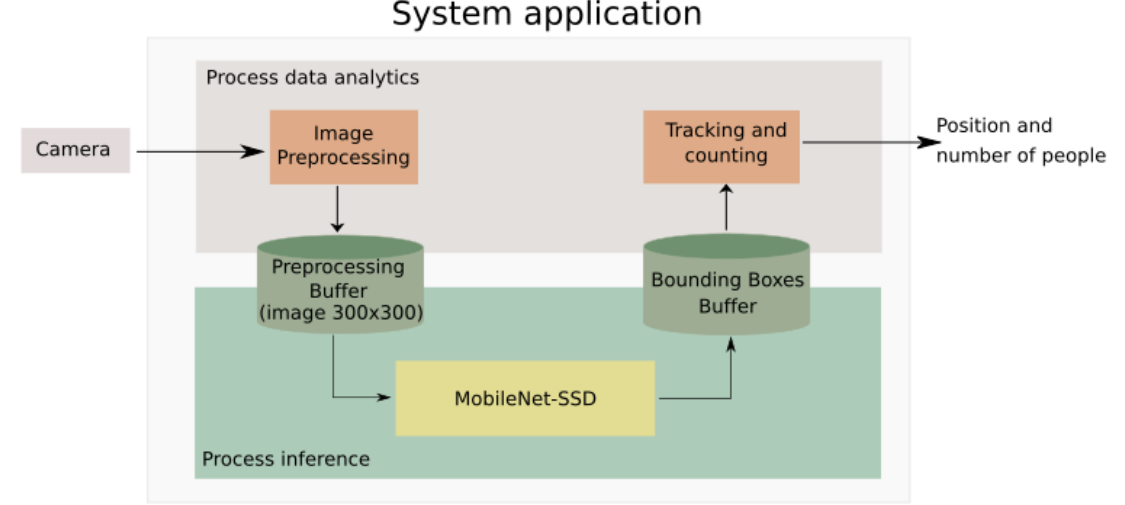
Figure 2. Data flow and multiple thread